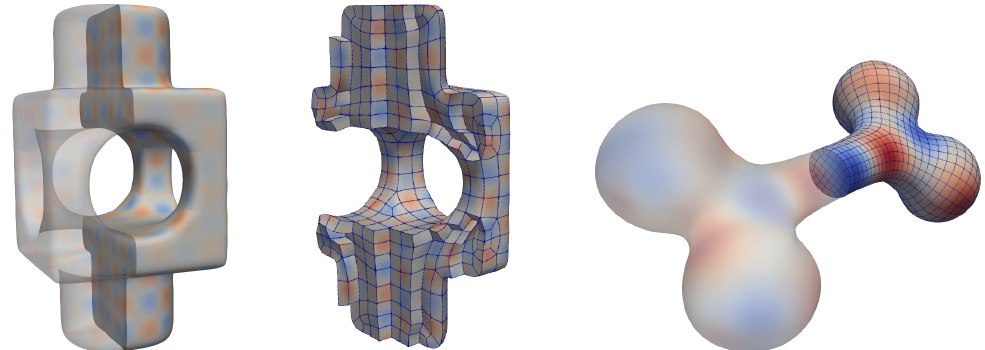
Figure 1. Using tri-3 C 1 splines to model smooth, curved domains from box-complexes and solving volumetric higher-order partial differential equations on this domain